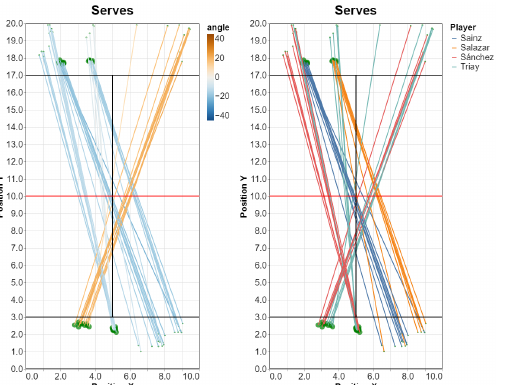
Figure 14. Serve directions, colored by angle ( left ) or by player ( right ). Please recall that, for all plots in this paper, we considered a subset of the points (this is not needed when using the interactive and zoomable